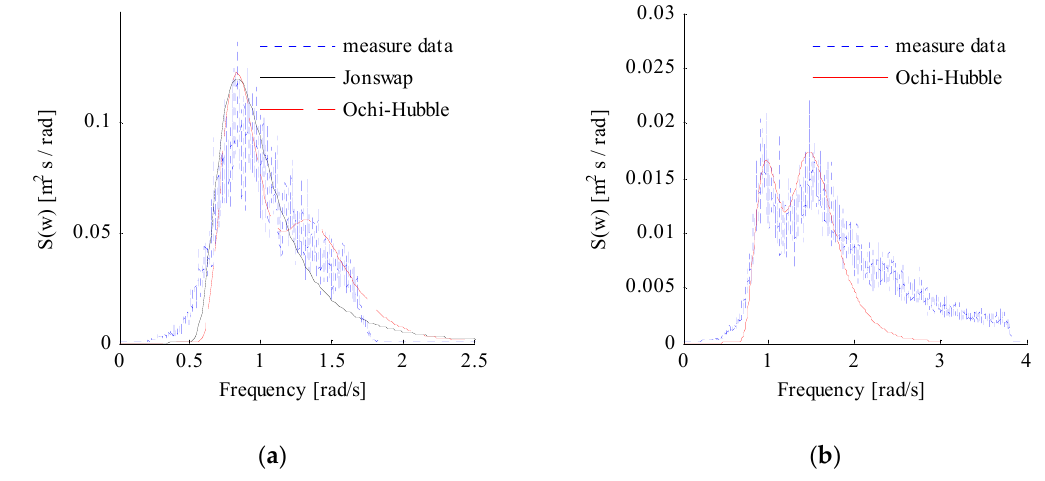
Figure 8. Regressed spectrum during pipeline end termination (PLET) installation and theoretical spectrum for ( a ) H s = 1.0583 m and ( b ) H s = 0.6069 m.